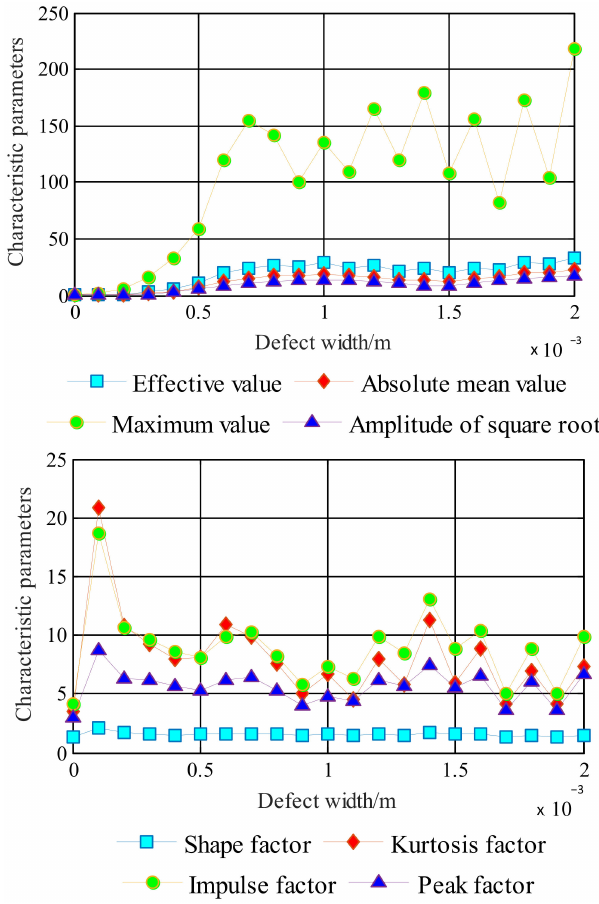
Figure 22. Influence of defect width on dimensional